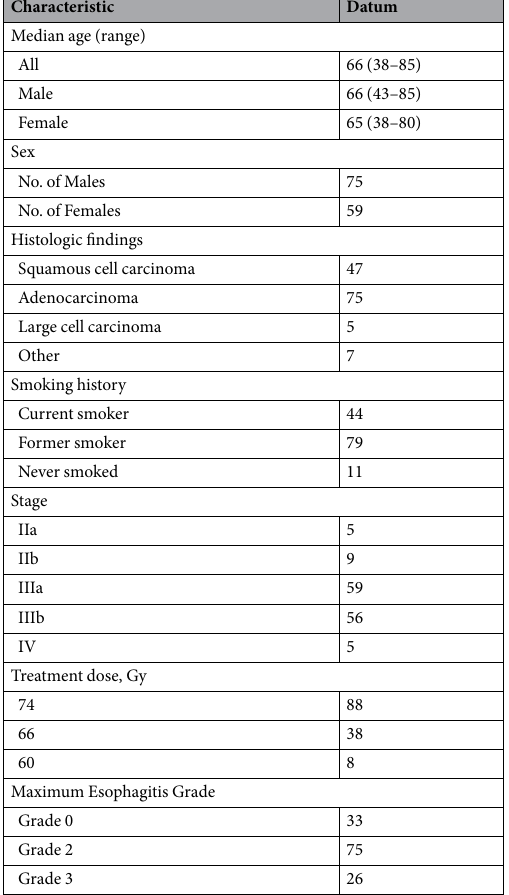
Table 1. Demographics of study patients (n = 134).